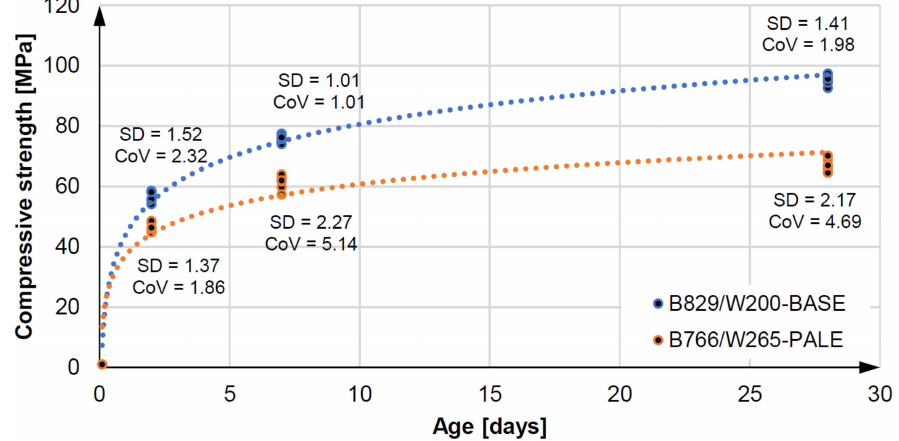
Figure 9. Compresive strenght and statistic parameters of 3D